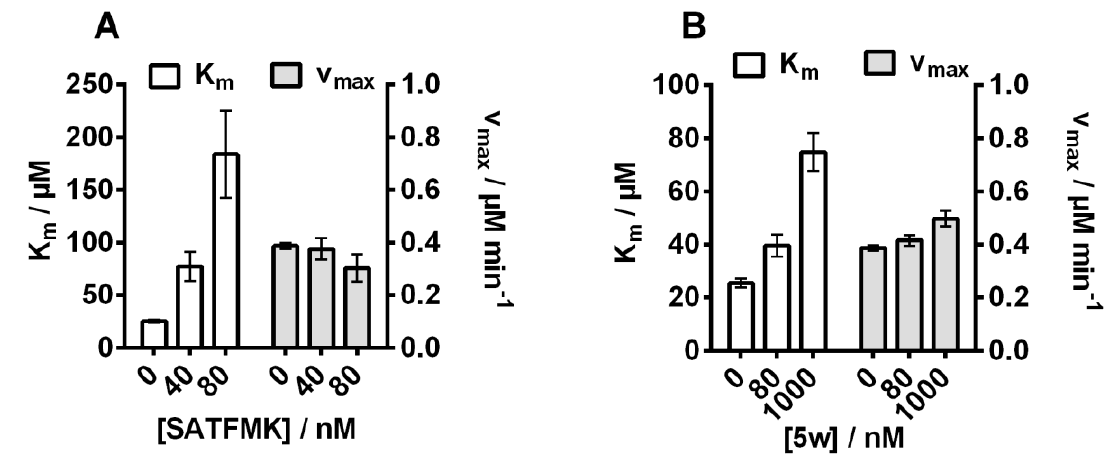
Figure 2. Michaelis Menten parameters for the determination of the mode of action with increasing compound concentration. K m - and V max -values of ( A ) SATFMK and ( B ) TZD ligand 5w showed increasing and stagnating values, respectively, as expected for a competitive inhibitor. Shown data represent means and standard deviations, N =